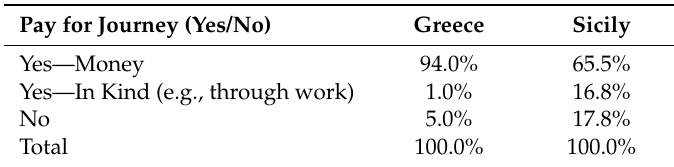
Table 4. Did you pay for your journey?